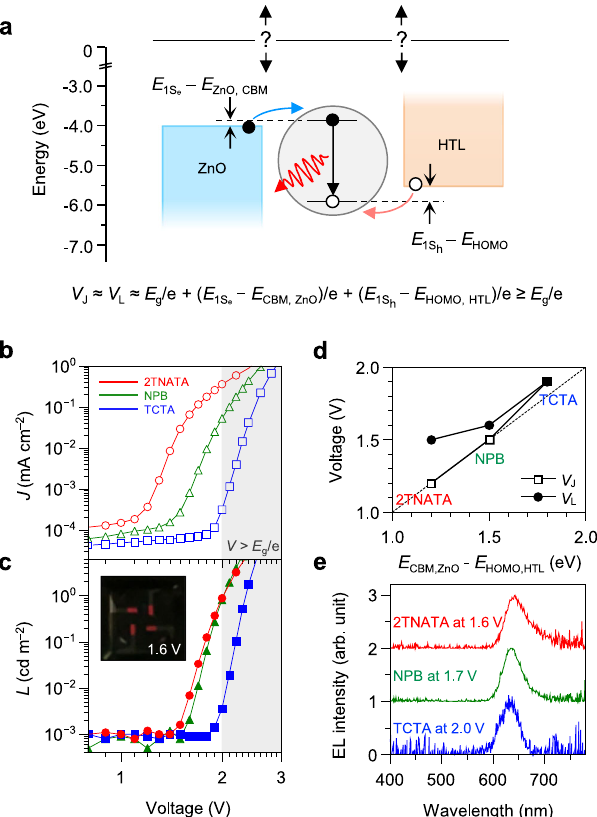
Fig. 1 Sub-band gap operation of quantum dot light-emitting diodes with energy band discontinuity. a Energy level diagram for materials used in this study without taking the interface modi fi cation into consideration. The equation estimates the current threshold ( V J ) of QLEDs under the assumption that series resistance is negligible. b Current density ( J ) – voltage ( V ) (open symbols) and c luminance ( L ) – voltage (closed symbols) characteristics of QLEDs employing 2TNATA (red circle), NPB (green triangle), and TCTA (blue square) HTLs. Grey shaded region indicates V > E g /e ( = 1.97 V), where E g is a bandgap of QDs. Inset shows a photographic image of 2TNATA-based QLEDs taken at an applied bias of 1.6 V. The pixel size of devices is 1.4 × 3.0 mm 2 . d V J and luminance thresholds ( V L ) plotted to E CBM, ZnO − E HOMO, HTL , where E CBM, ZnO is the CBM of ZnO and E HOMO, HTL is a HOMO level of HTL. Dashed line indicates V = ( E − E CBM, ZnO HOMO, HTL )/e for eye guidance. e EL spectra of QLEDs with different HTLs acquired at near V L